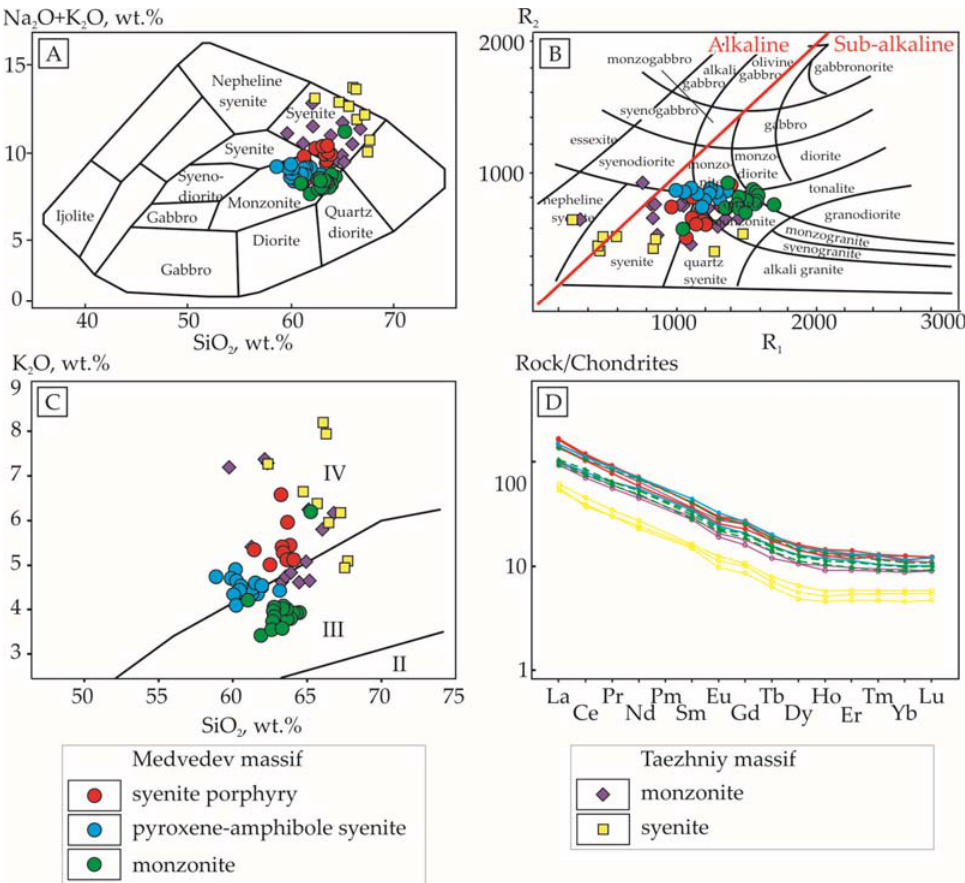
Figure 4. Classification diagrams for igneous rocks of the Medvedev and Taezhniy massifs. ( A ) diagram (Na 2 O + K 2 O) − SiO 2 [42], adopted for plutons by [37]; ( B ) diagram (R 1 − R 2 ) [38]. R 1 = 4Si − 11(Na + K), R 2 = 6Ca + 2Mg + Al; ( C ) K 2 O–SiO 2 diagram [39], fields: II—medium ‐ potassium calc ‐ alkaline, III—high ‐ potassium calc ‐ alkaline, IV—shoshonite; ( D ) distribution of REE elements, normalization to chondrite [41].